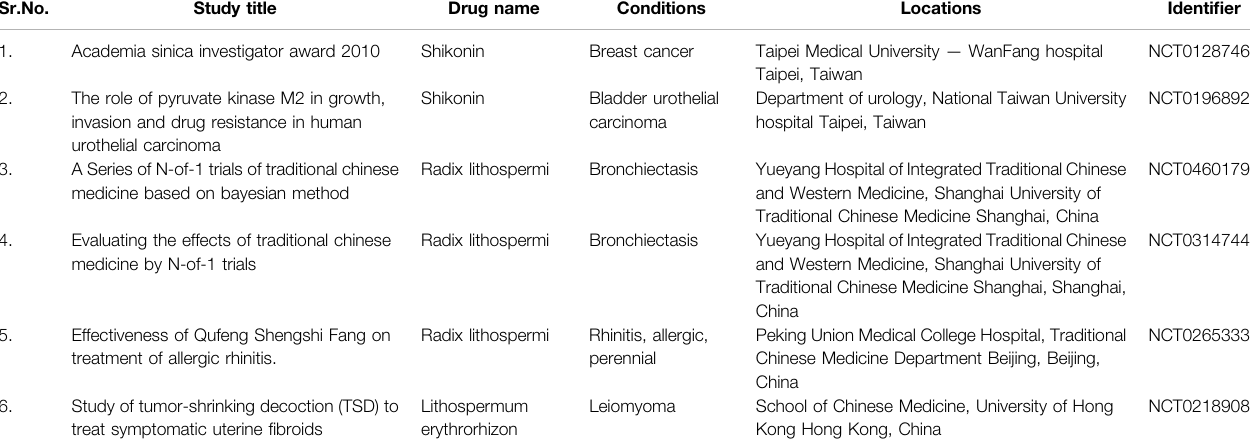
TABLE 9 | Clinical trials registered on clinicaltrials.gov related to shikonin and shikonin producing species (source- https://clinicaltrials.gov/and Sun et al., 2022).